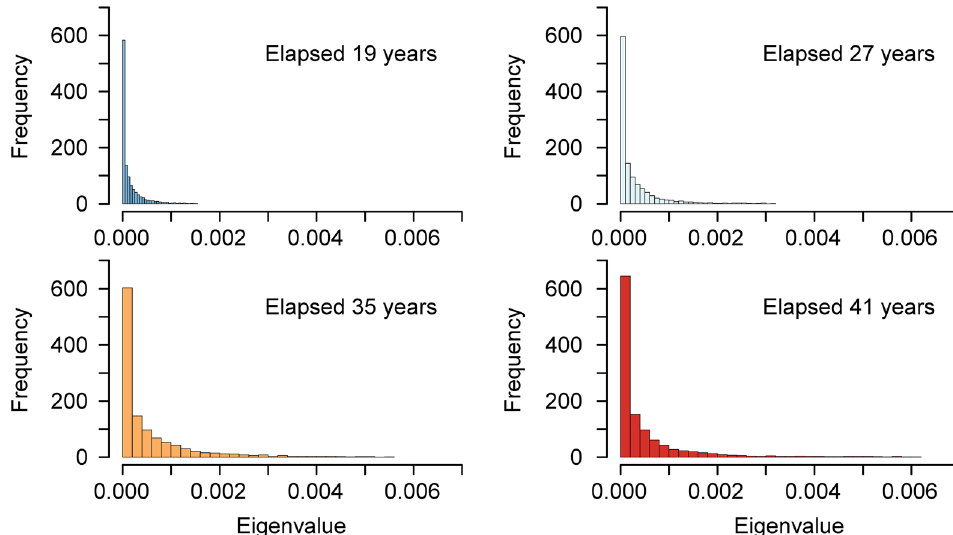
Fig. 2 Distributions of eigenvalues at representative elapsed